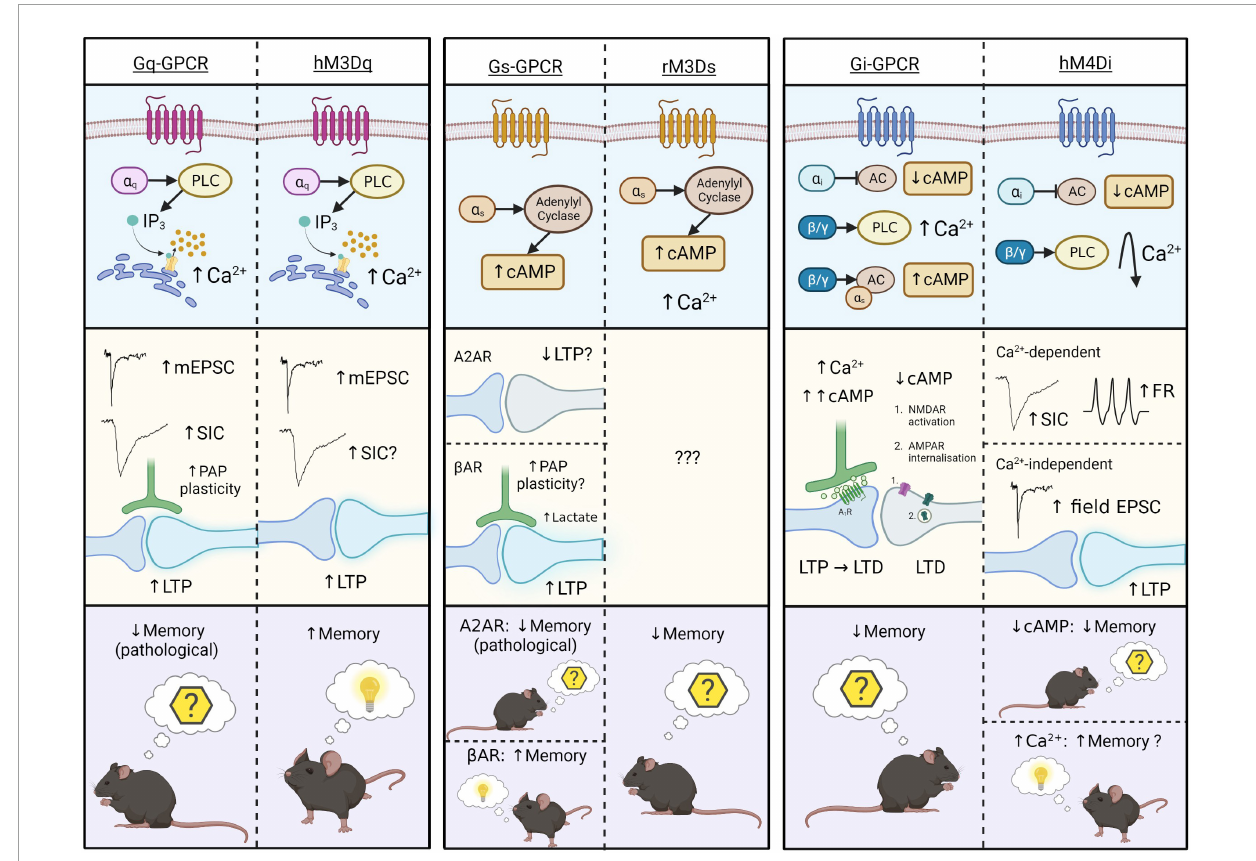
FIGURE2 Schematic representation of intracellular (top) , synaptic (middle) , and behavioral (bottom) effects of endogenous Gq-, Gs-, and Gi-GPCR stimulation in astrocytes, and that of corresponding Gq-, Gs-, and Gi-DREADDs (hM3Dq, rM3Ds, and hM4Di). Astrocytic Gq-GPCRs/hM3Dq activation (left) evokes Ca 2 + elevations via the PLC-IP 3 signaling pathway. This increases mEPSCs, SICs (conflicting evidence for hM3Dq), LTP and PAP plasticity at synapses. Only one study illustrates memory-related behavioral effects of Gq-GPCR activation in astrocytes – in